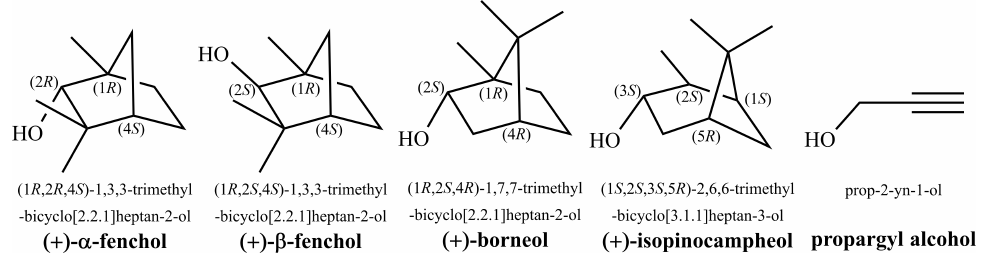
Figure 1. Structural formulas, systematic names and used trivial names of alcohols discussed in this